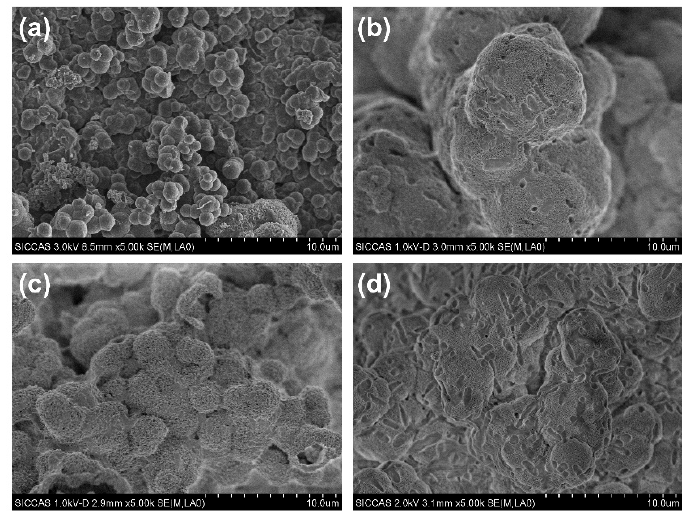
Figure 10. SEM images of C2S and Sr-C2S after immersion in SBF solution for 7 days: ( a ) C2S; ( b ) Sr1-C2S; ( c ) Sr5-C2S; ( d ) Sr10-C2S.